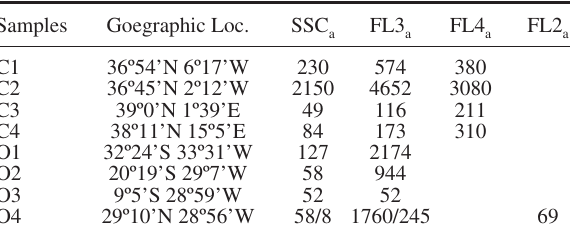
Table 1. – Geographic locations and cytometric data of the eight samples exposed to toxicity assays with copper (coastal samples C1-C4, oceanic samples O1-O4). Subscript “a” on SSC (side- scatter, cell size), FL3 (chlorophyll a autofluorescence), FL4 (phy- cocyanin), and FL2 (phycoerythrin), indicates data corresponding to average arbitrary